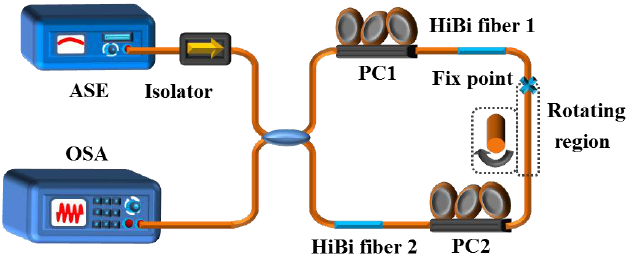
Figure 1. Experimental setup of the Lyot-Sagnac interferometer. ASE: Amplified spontaneous emission; HiBi: High-birefringence; OSA: Optical spectrum analyzer; PC: Polarization controller.